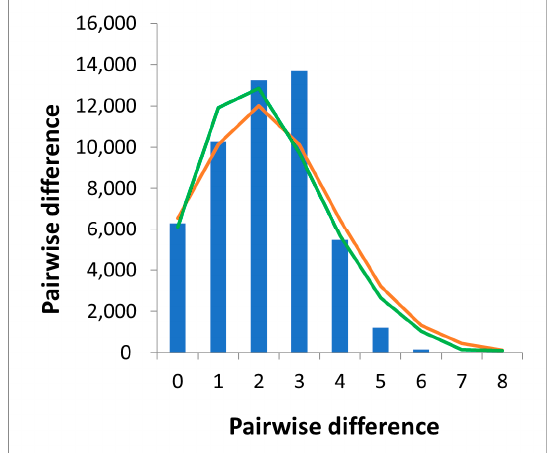
Figure 4. Diagram of the mismatch distribution (MMD) of pairwise differences of the COI sequences of Margaritifera margaritifera from the WS group of populations. Simulated MMD under expectations of spatial expansion is marked by the orange line, and that under sudden population expansion is marked by the green line.